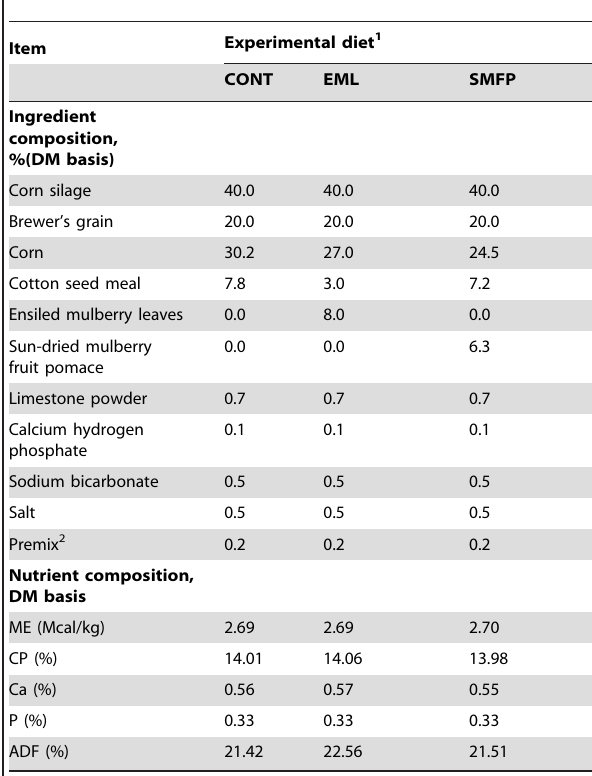
Table 1. Ingredients and nutrient composition of the experimental